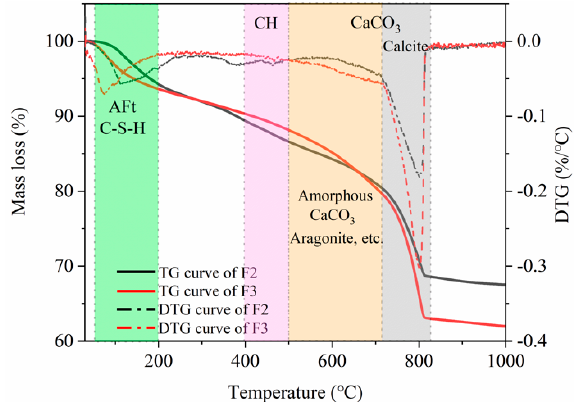
Figure 11. TG analysis of self-healing products.